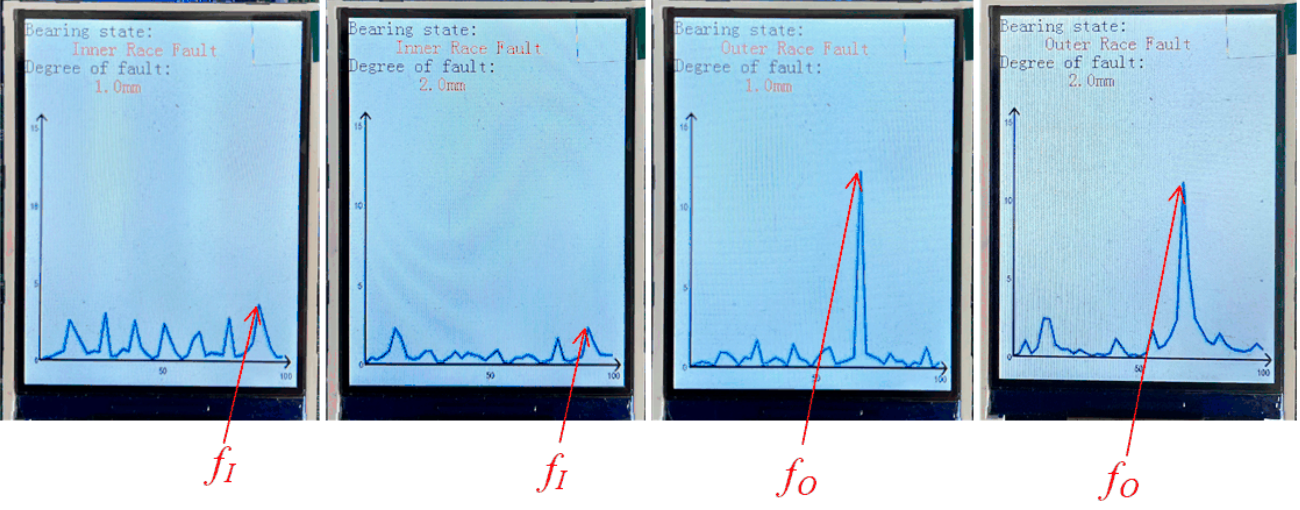
Figure 16. Offline bearing diagnostic status display. Table 9. Comparison of different